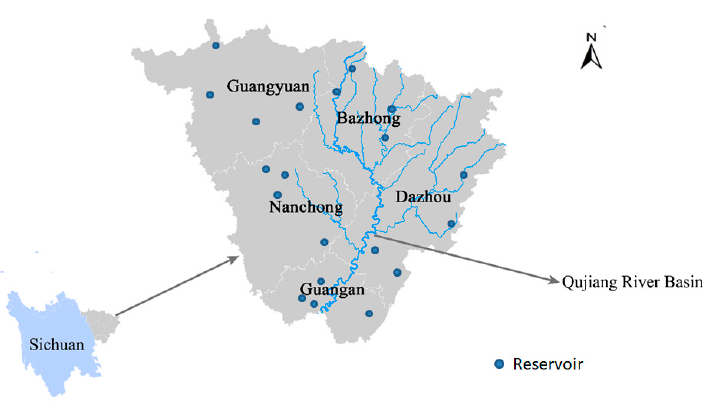
Figure 2. Location of the Qujiang River Basin in Sichuan province.